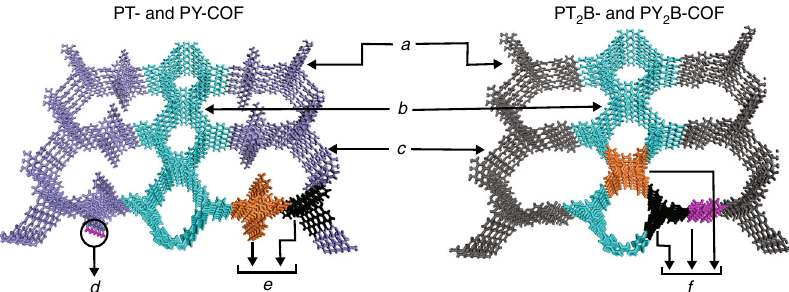
Fig. 8 Summary of the unique features of the sub-stoichiometric and the three-component COFs. a bex network topology. b Supramolecular ribbon-like motifs as secondary building units for hierarchical design. c Highly crystalline and porous, dual pore COFs. d Free functional groups by sub-stoichiometric design — free amines in an imine-linked COF, functionalizable, and catalytically active. e Combination of tetratopic and triangular linkers — dual linking mode of tetratopic molecule. f Combination of di-, tri-, and tetratopic